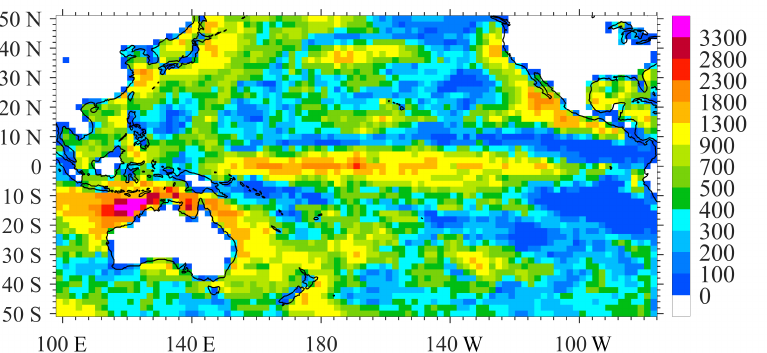
Figure 4. Spatial distributions (color shading) of MWHS-2 clear-sky marine data counts in 2 ◦ × 2 ◦ grid boxes from 24 September to 8 October